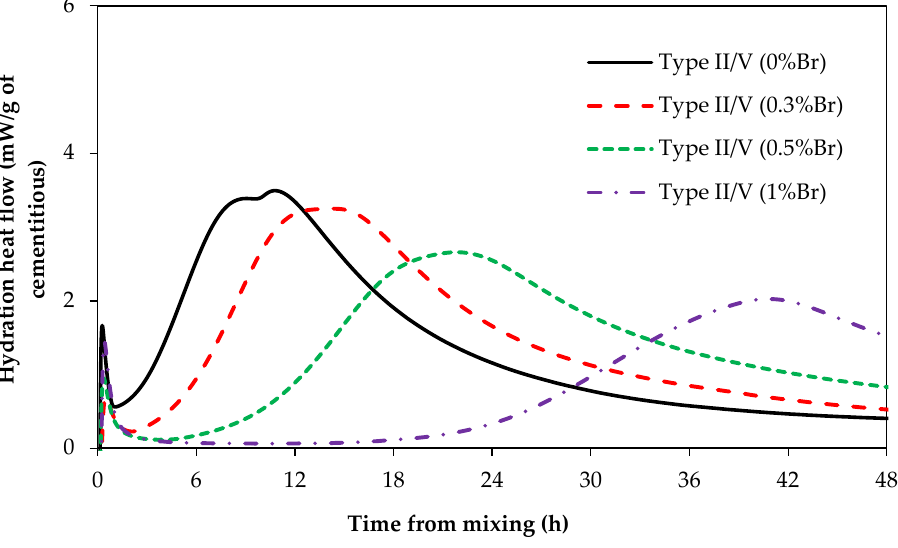
/ V hydration with and without Figure 5. Type II/V hydration with and without borax . Figure 5. Type II